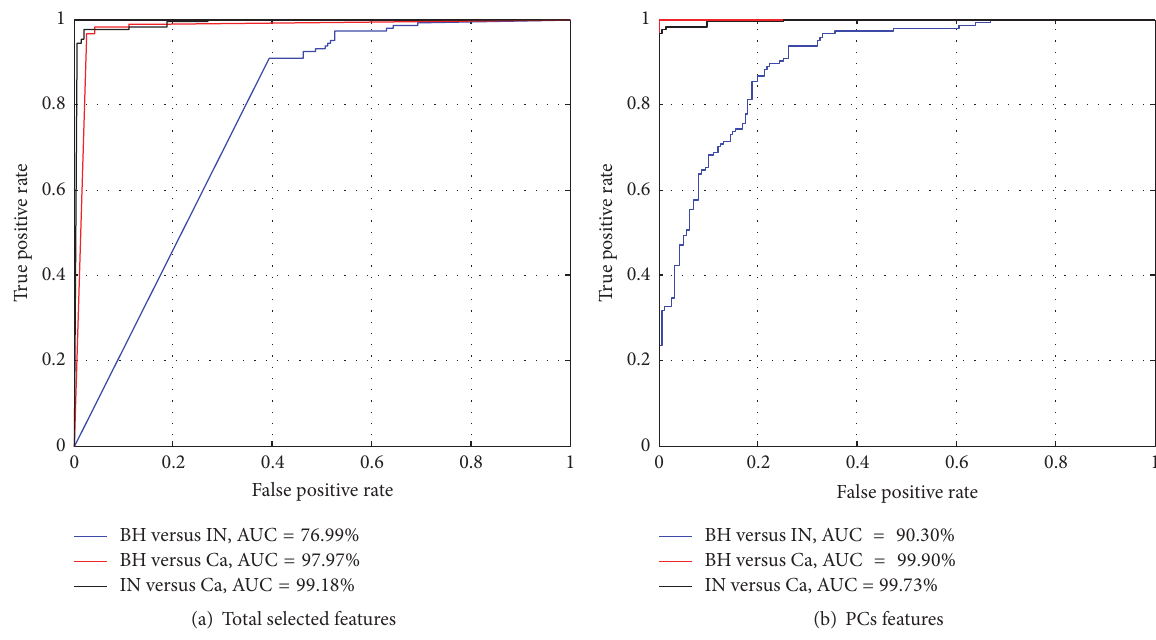
Figure 5: Receiver operating characteristic (ROC) curves were determined for each discrimination between ABC (BH versus IN, BH versus Ca, and IN versus Ca) problems based on real 3D data. The area under the curve (AUC) values achieved are shown for each discrimination between ABCs in two cases: (a) total selected feature used is 158 and (b) PCs features used are 5.